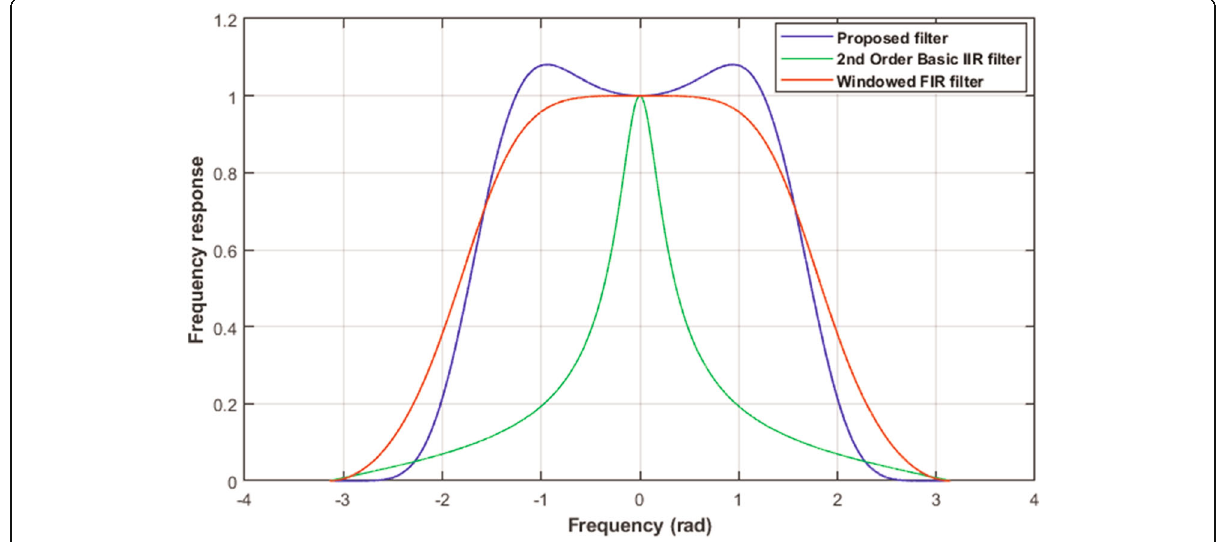
Fig. 6 Frequency response for the proposed low-pass filter, compared to a continuous-time low-pass filter after